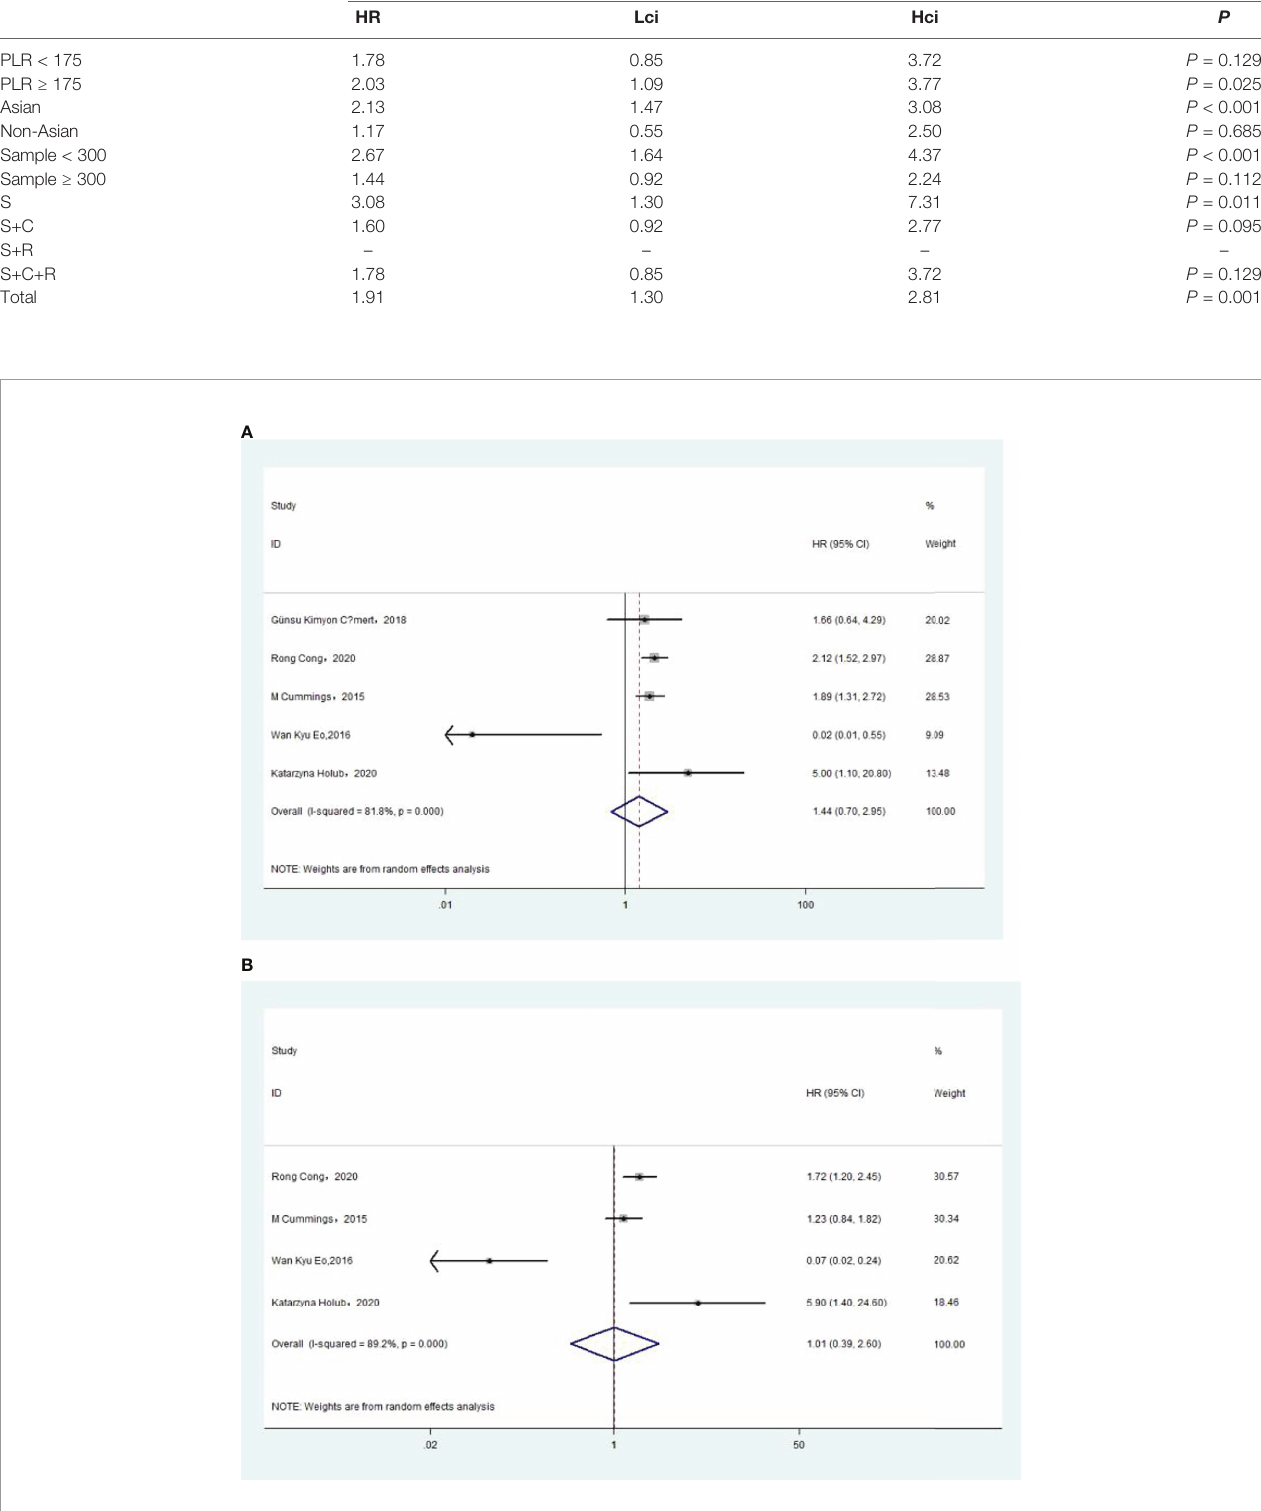
FIGURE 7 | (A) Relationship between monocyte – lymphocyte ratio (MLR) and overall survival (OS) in univariate analysis. (B) Relationship between MLR and OS in multivariate